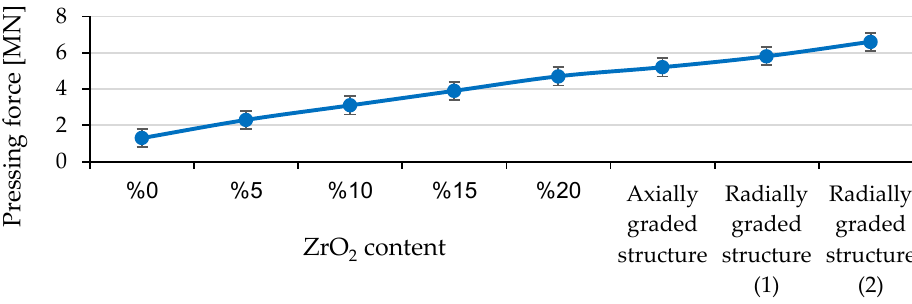
Figure 5. Compressive forces required for different ZrO 2 contents and the graded structure to achieve full density.